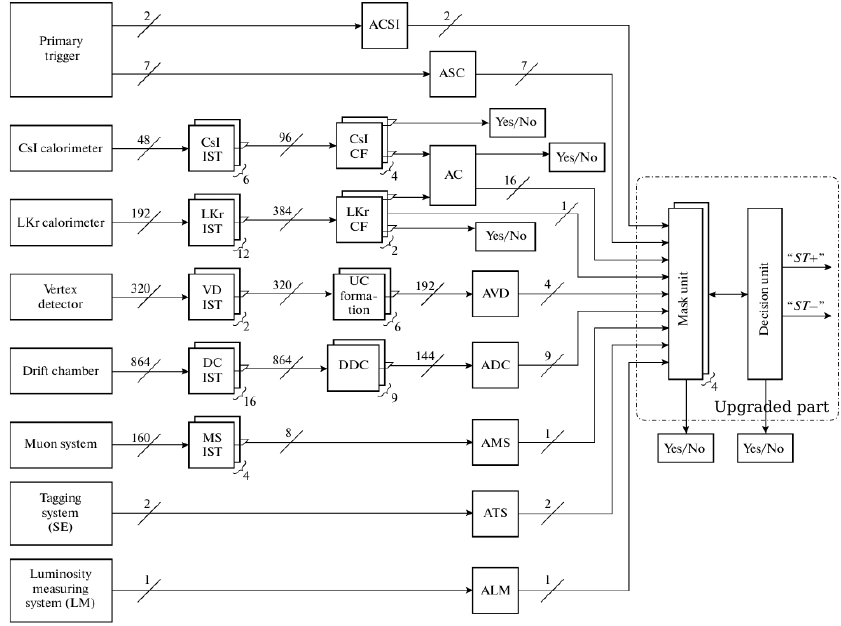
Figure 3. Block diagram of the secondary trigger, with ACSI — arguments of the CsI, ASC — argu- ments of Scintillators, AC — arguments of Calorimeters, AVD — arguments of the Vertex Detector, ADC — arguments of the Drift Chamber, AMS — arguments of the Muon System, ATS — arguments of the Tagging System, ALM — arguments of the Luminosity system, UC — Universal Cell, CF — Cluster Finder, DDC — discriminator of the Drift Chamber, Yes / No — KLUKVA information boards to catch the trigger “arguments” or “masks” for each